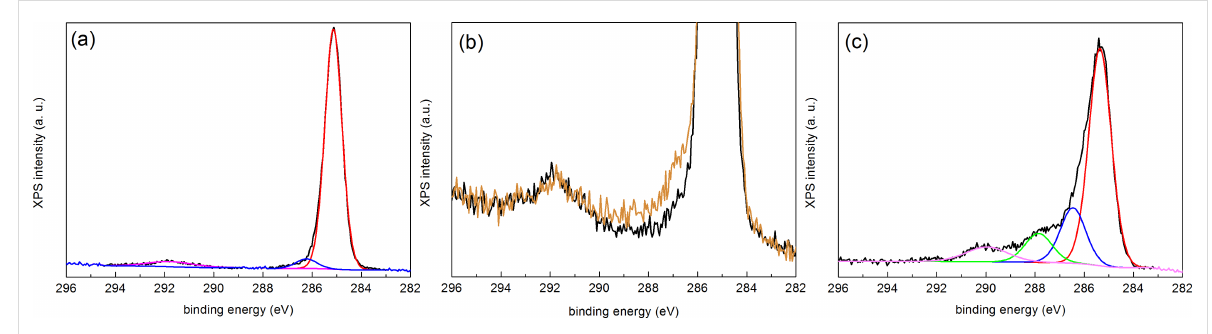
Figure 3: HAXPES spectra corresponding to the C 1s region of grafted PS–OH samples (a) cooled in nitrogen, (b) cooled in air (orange) and in nitrogen (black) and (c) cooled in nitrogen and exposed to oxygen plasma, taken with 2020 eV using a SCIENTA R4000 hemispherical analyser. Least-square fits of the experimental data (continuous black line) after background subtraction (Shirley-type) are shown in (a) and (c) using a combi- nation of Gaussian (70%) and Lorentzian (30%) functions under the constraint of identical full width at half maximum (FWHM) values for all compo- nents.